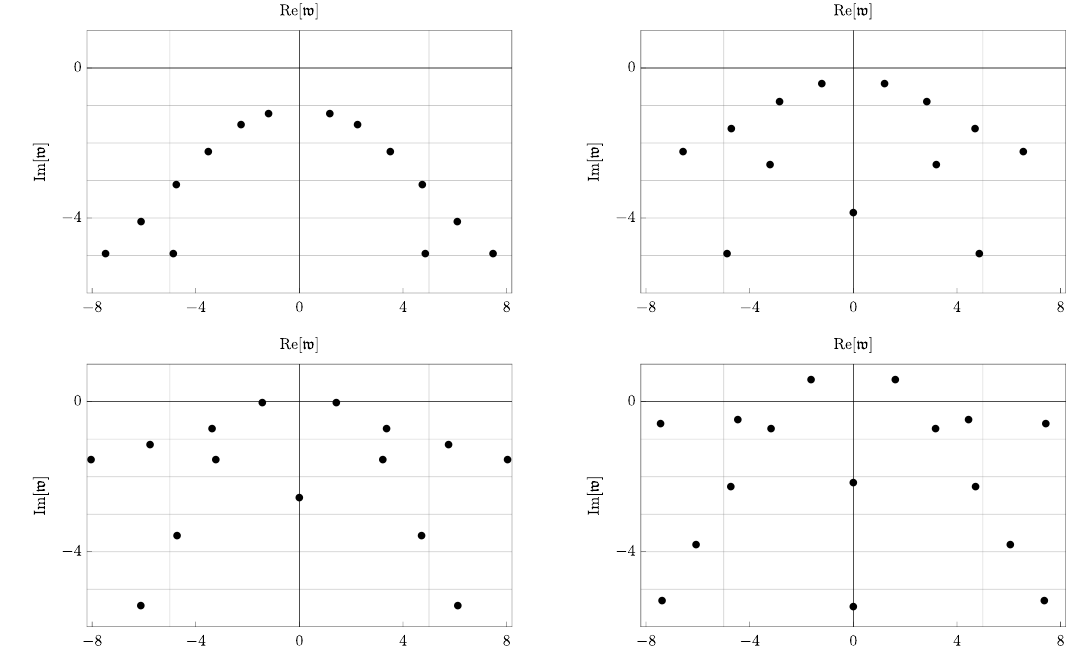
Figure 6 . The scalar channel spectrum at q = 0, plotted for (cid:11) = f 0 : 01 ; 0 : 04 ; 0 : 06 ; 0 : 08 g and (cid:13) 2 = 0 : 05, from top-left, top-right to bottom-left and bottom-right.